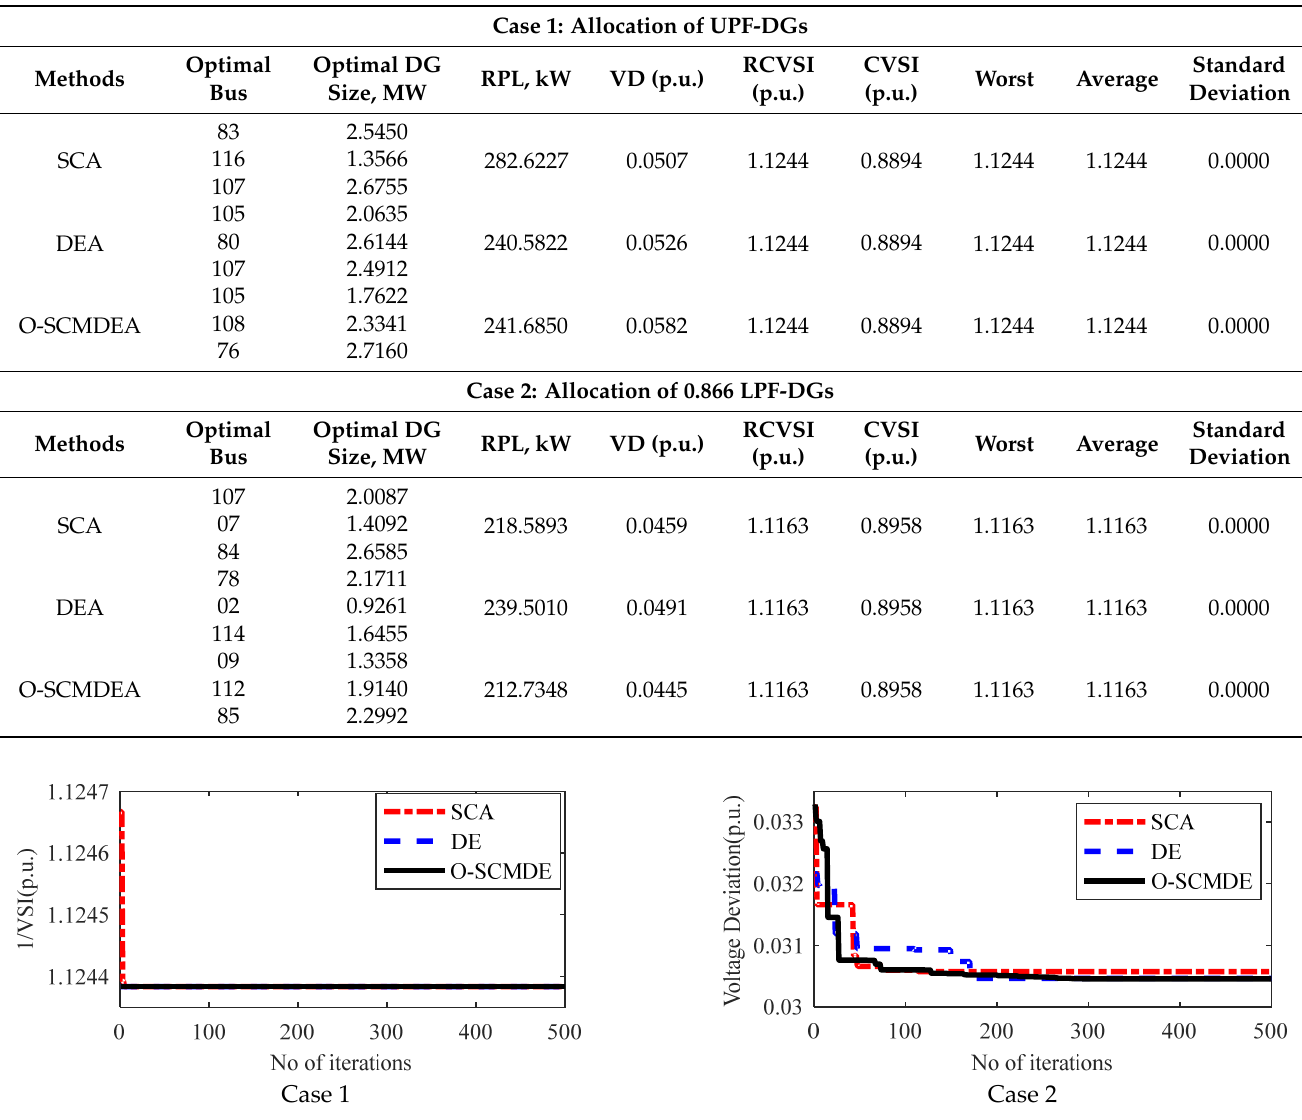
Table 14. Comparison of the results for the RCVSI minimization of 136 bus DN.